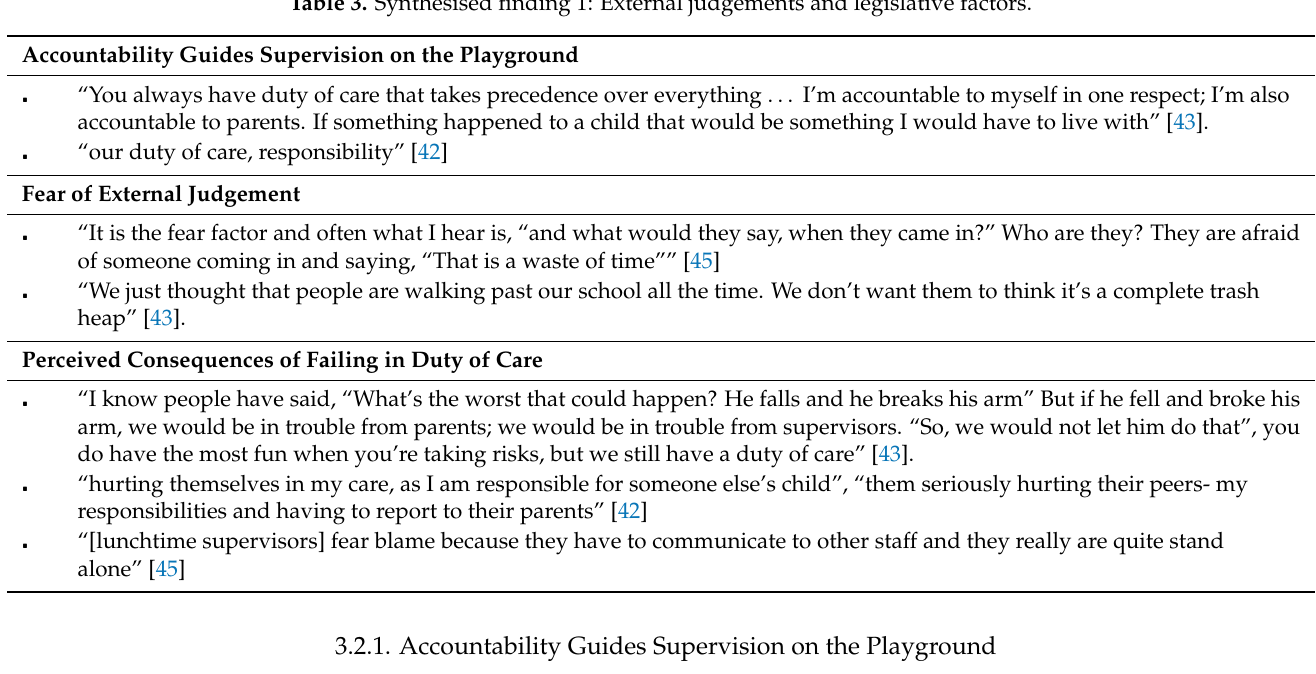
Table 3. Synthesised finding 1: External judgements and legislative